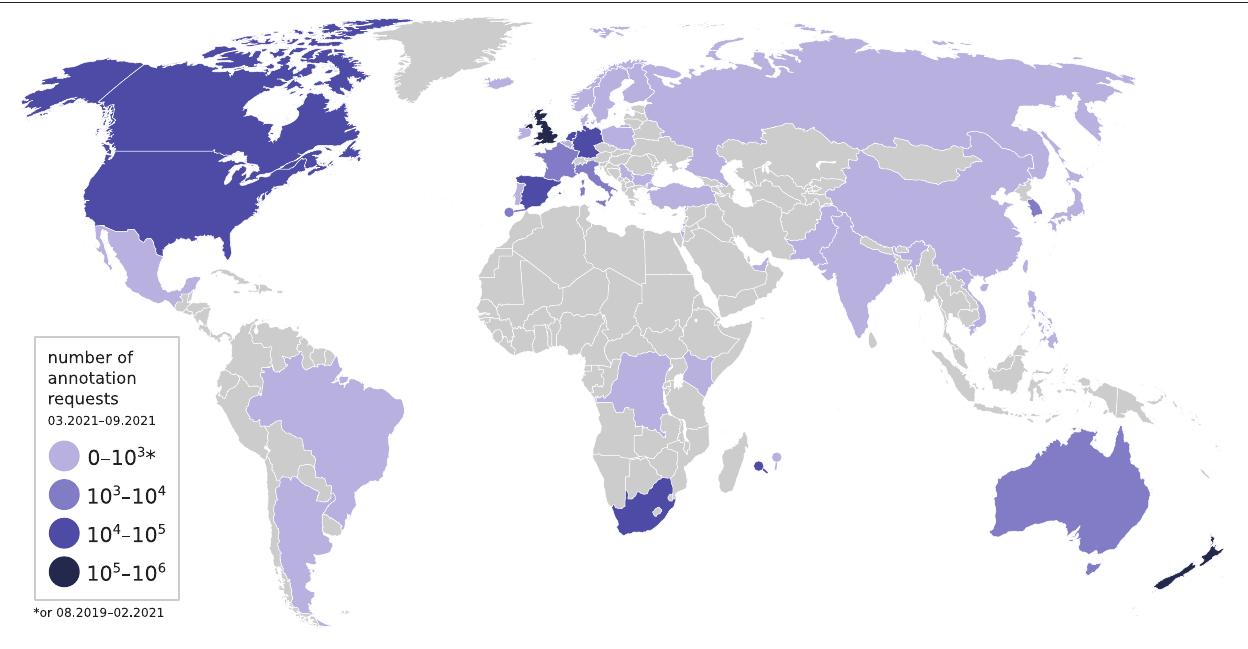
FIGURE 2 | Countries from which annotation requests have been sent to biigle.de between March and September 2021. The countries are split into four groups depending on the number of annotation requests that were sent from the respective country. The group of countries with 0 − 10 3 requests also includes countries from which any requests were sent between August 2019 and February